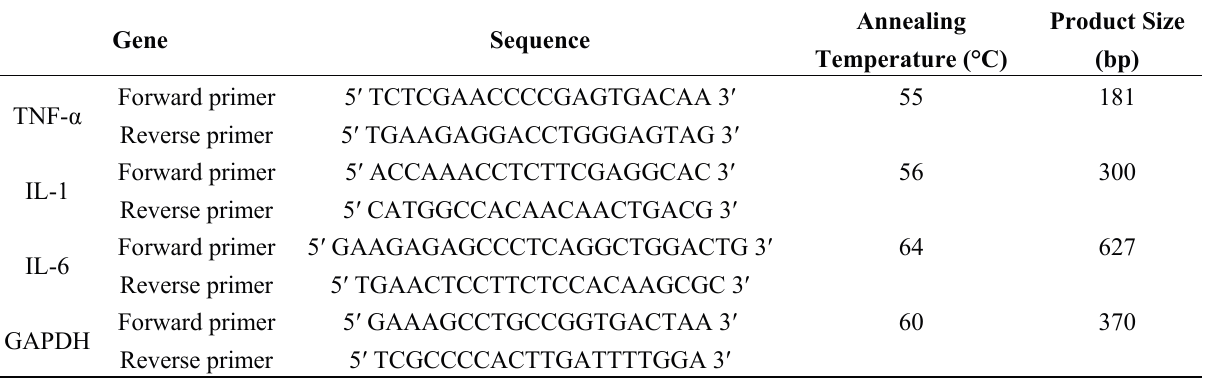
Table 1. Specific nucleotide primers used in qPCR.